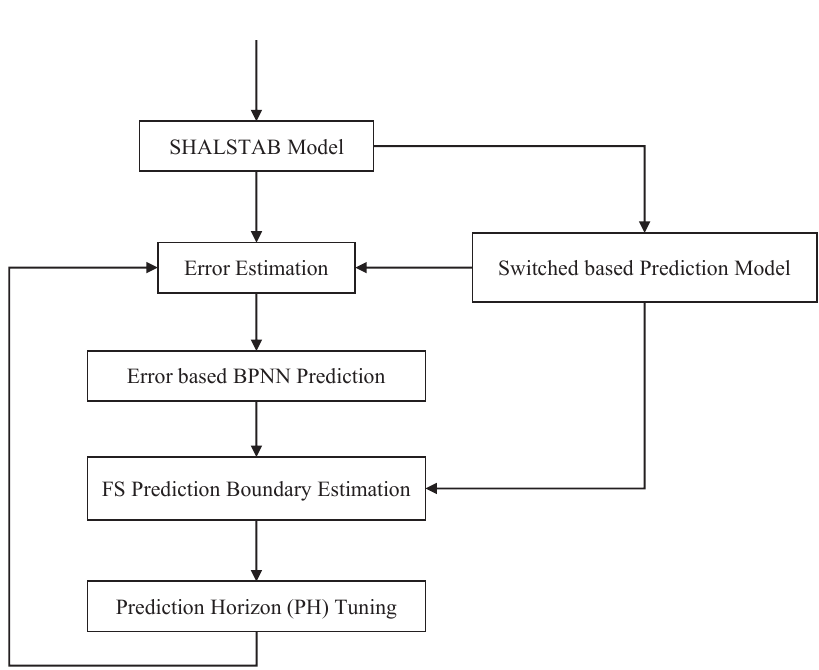
Figure 9. Prediction horizon tuning.